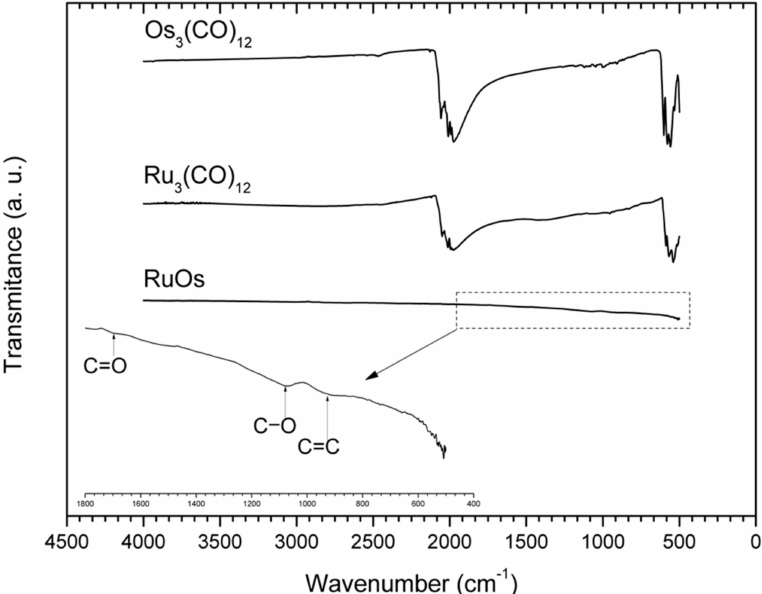
Figure 2. FT-IR spectra of the OsRu electrocatalyst synthesized at 180 ◦ C by microwave radiation in 1,2-dichlorobenzene and the precursors Os 3 (CO) 12 and Ru 3 (CO) 12